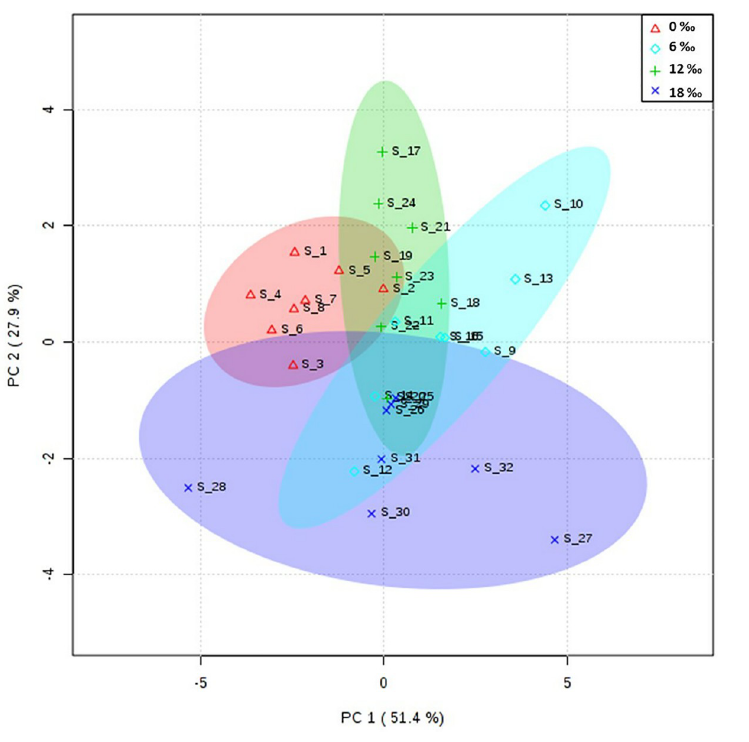
Fig 2. PCA scores plot of fatty acids profiles in the gonads of adult female E . sinensis